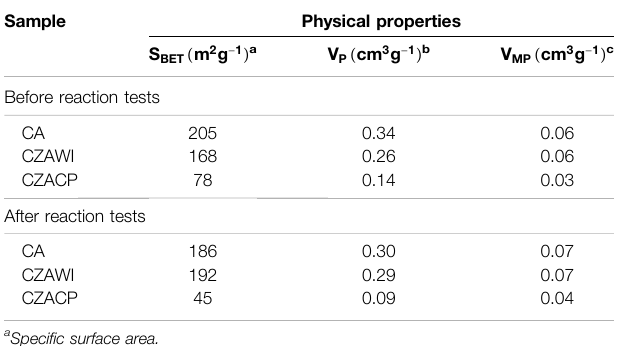
TABLE 1 | Physical properties for samples.